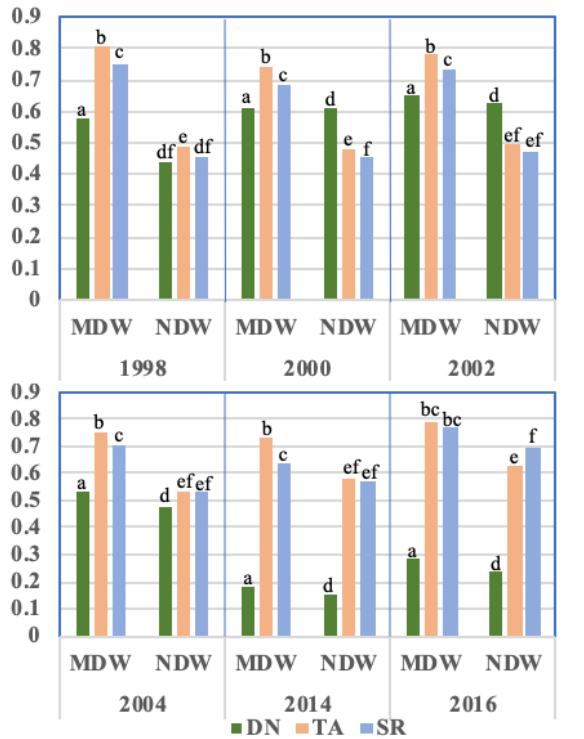
Figure 5. Average values of the Modified Normalized Difference Water Index (abbreviated MDW in the graph) and the Normalized Difference Water Index (abbreviated NDW in the graph) of shallow water for three pre-processing levels (DN, TA, SR) across six years. Letters denote significant difference (p <0.05) between pre-processing levels within a given index.